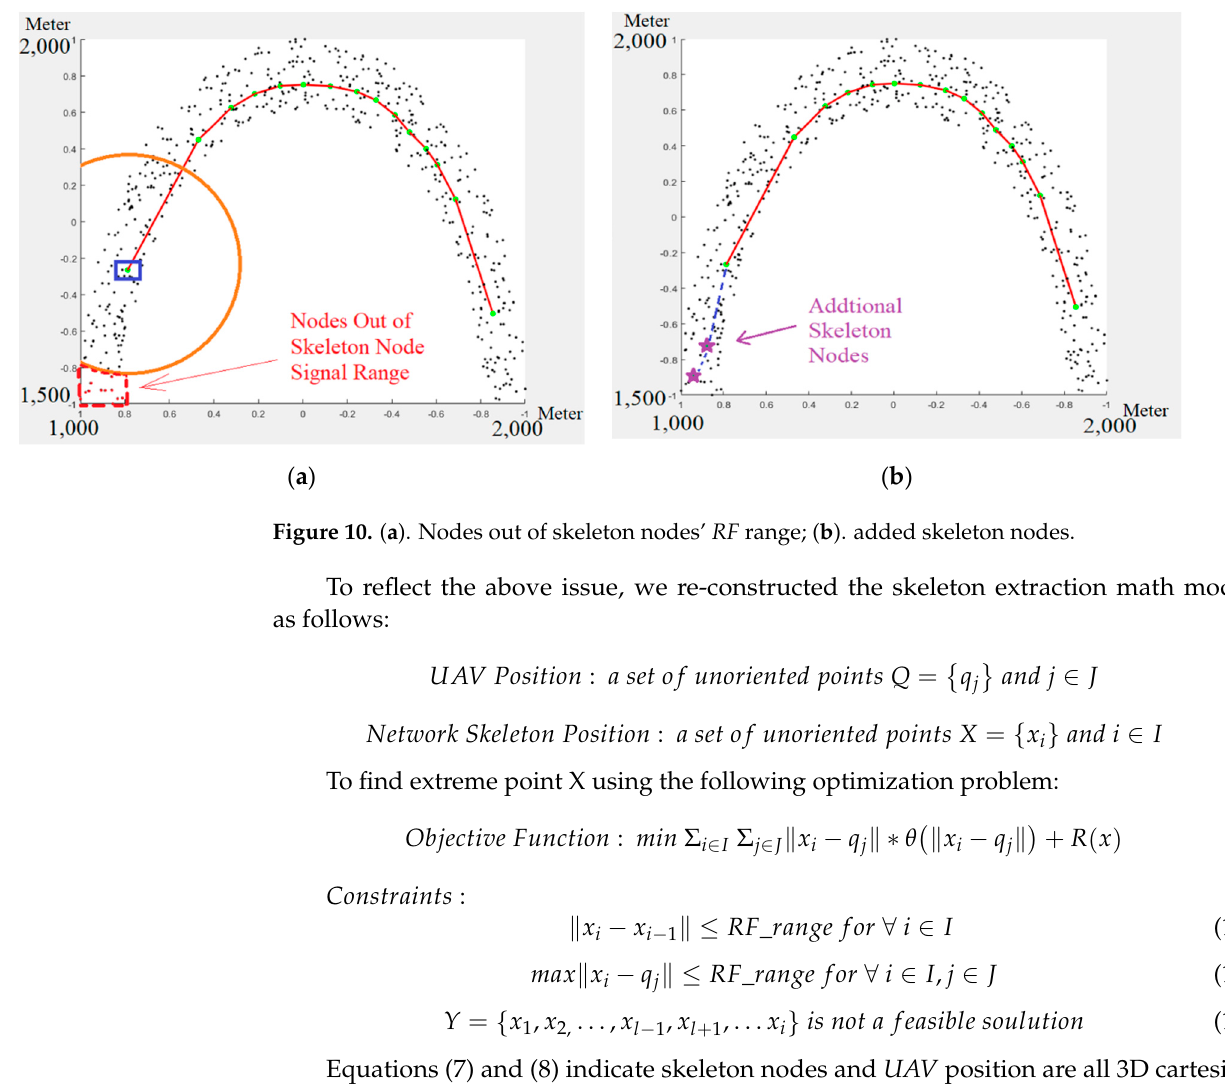
Figure 9. ( a ). Extracted skeleton for network size 100 m × 50 m; ( b ) size 1000 m × 500 m; ( c ) 10,000 m × 5000 m.